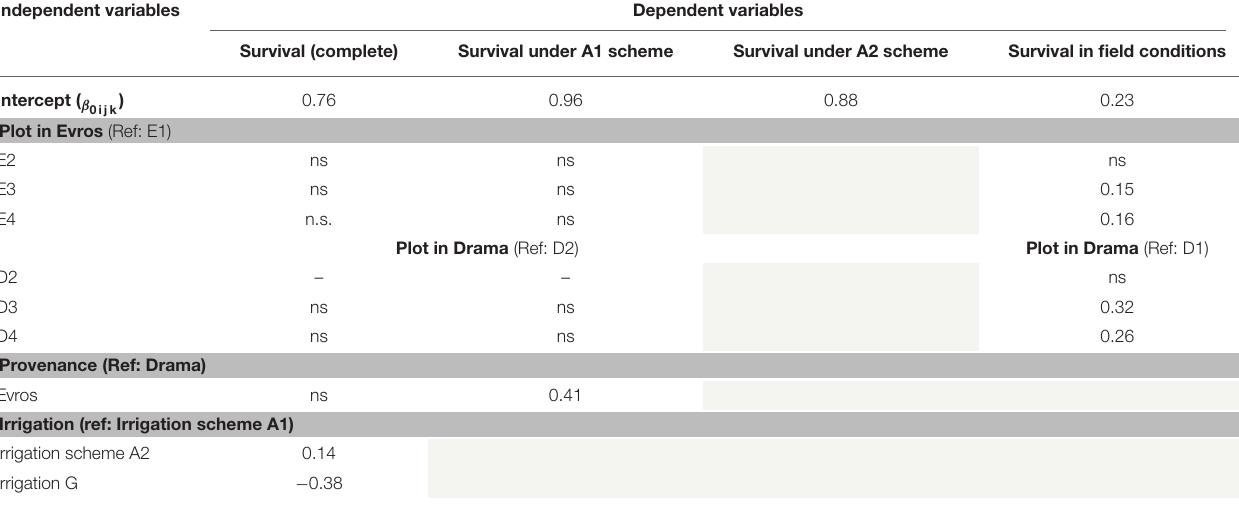
TABLE 3 | Parameter estimates for the best selected models (5% level of significance) for survival